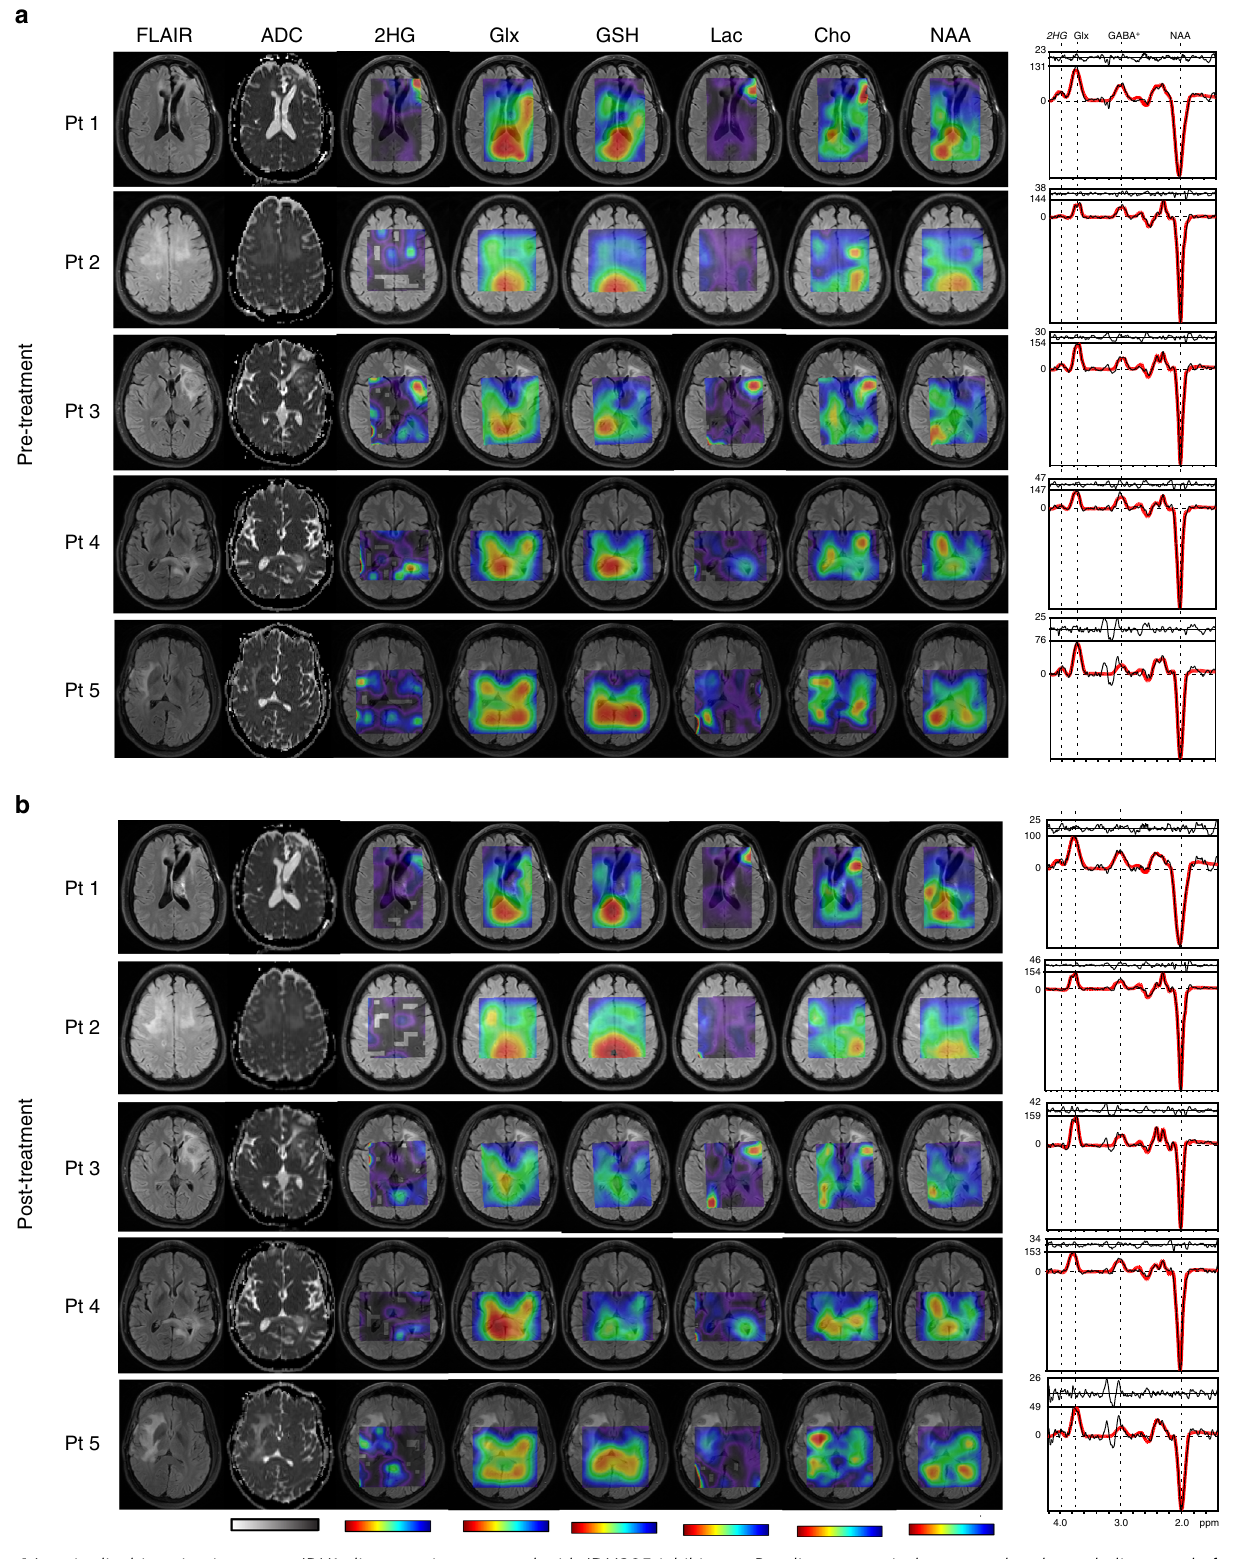
Fig. 1 Longitudinal imaging in mutant IDH1 glioma patients treated with IDH305 inhibitor. a Baseline anatomical, structural and metabolic maps before treatment. b Follow-up anatomical, structural, and metabolic maps after 1 week of IDH305 treatment. Metabolic maps are converted to mM by reference to healthy creatine levels. The color bars ranges are 0 – 3 mM (2HG), 0 – 20 mM (Glx), 0 – 1 mM (GSH), 0 – 16 mM (Lac), 0 – 3 mM (tCho), 0 – 20 mM (NAA), and 0 – 4 μ m 2 /ms (ADC). On the right, examples of 2HG edited spectra (black trace) and the LCModel fi ts (red trace) are